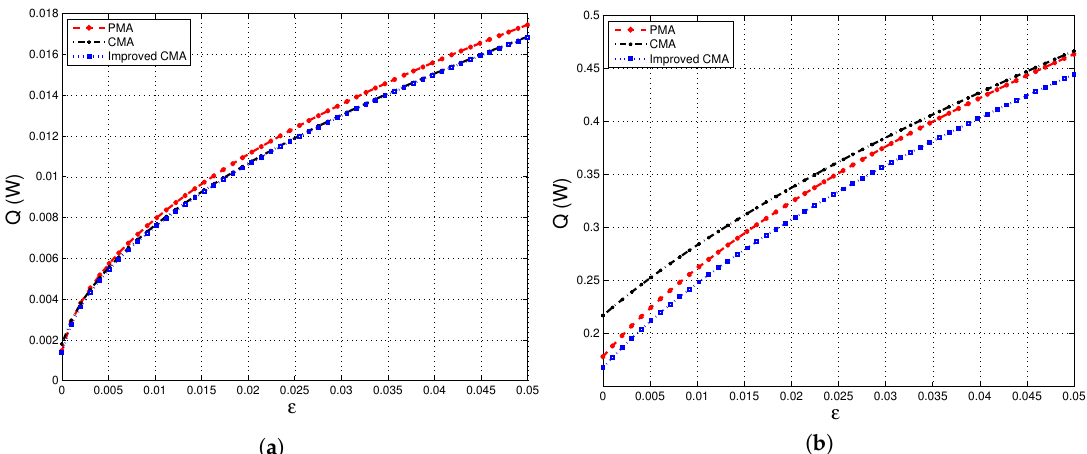
Figure 7. Heat flux versus compaction strain, ε , evaluated under different thermal gradients imposed at the boundary walls. ( a ) T w